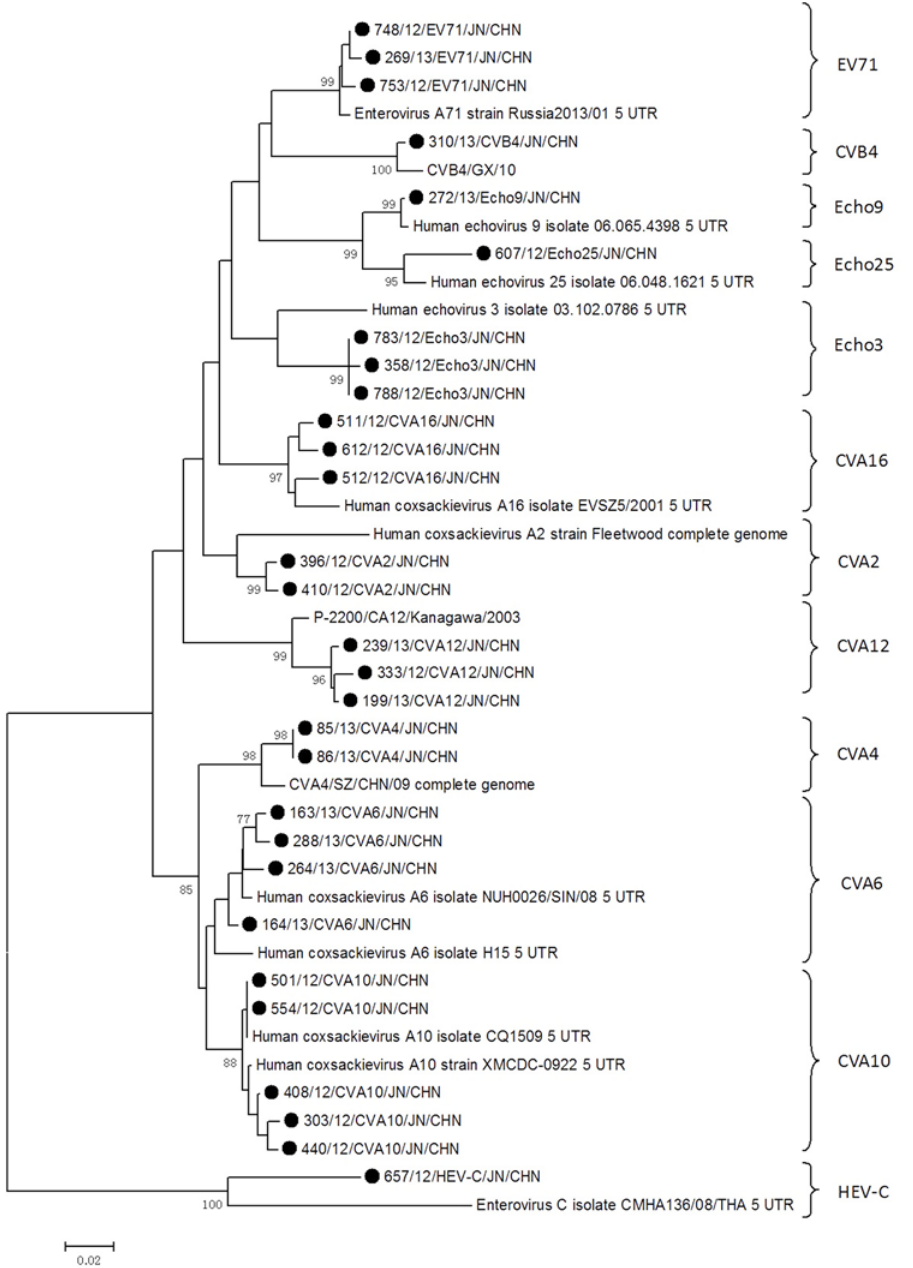
Fig 5. Phylogenetic analysis based on the 5 ’ -UTR region of HFMD cases during 2009 to June 2013 in Jinan, China. A total of 29 representative sequences (representing 12 serotypes) from this study and 12 reference strains worldwide were used to build the tree. Jinan sequences were labeled by black solid dot. Abbreviations: JN, Jinan; CHN,